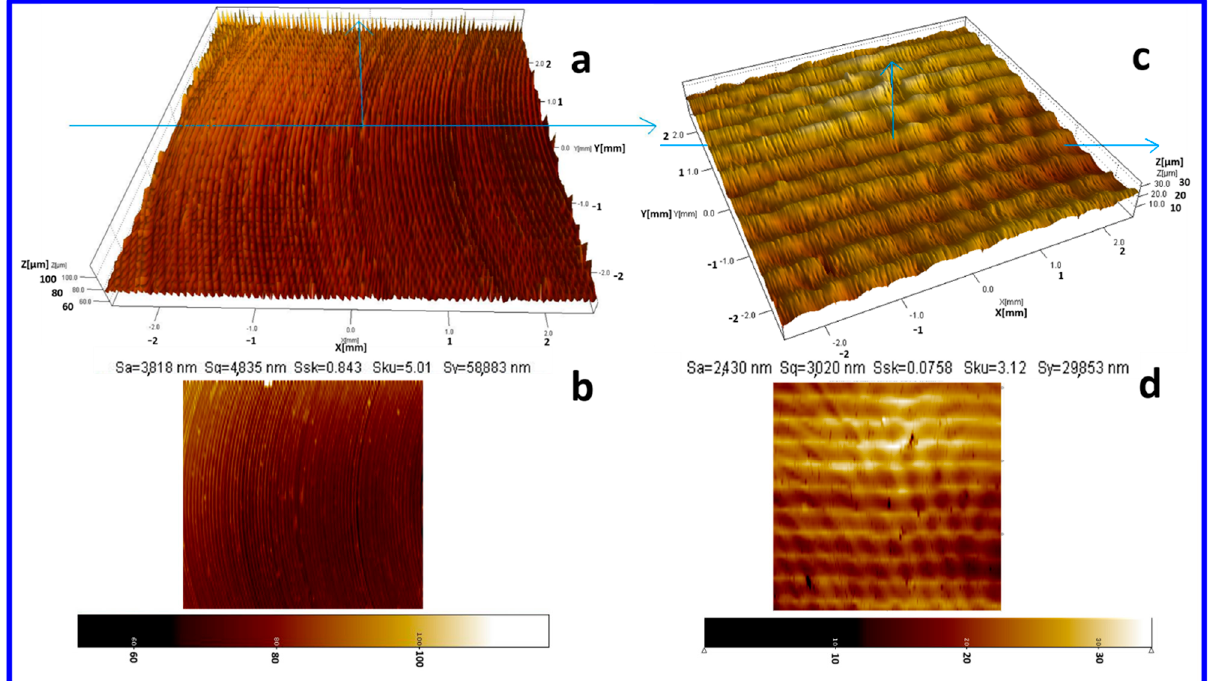
Figure 8. Surface topography and texture for Test 2: ( a ) surface 3D topography; ( b ) image report of roughness after FSW; ( c ) surface 3D topography; ( d ) image report of roughness after BB.